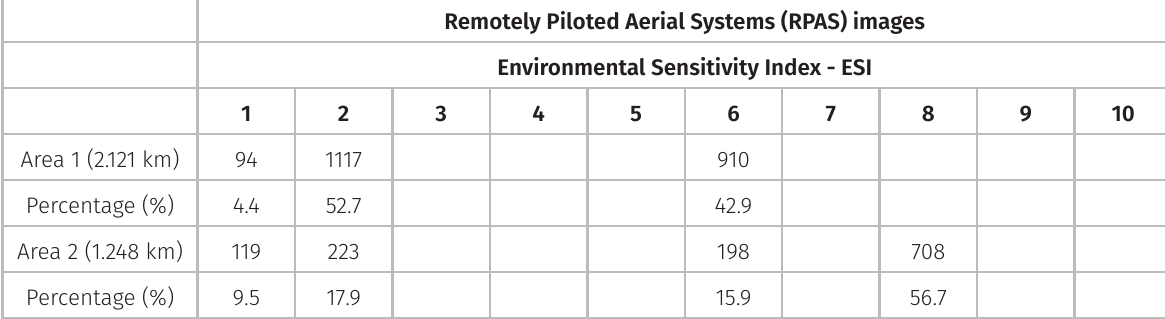
Table VIII. Table showing the total extension of each ESI class for Areas 1 and 2 and the corresponding percentage value of these in relation to the total length of the analyzed rocky shores extension. ESI values based on the Remotely Piloted Aerial Systems (RPAS)